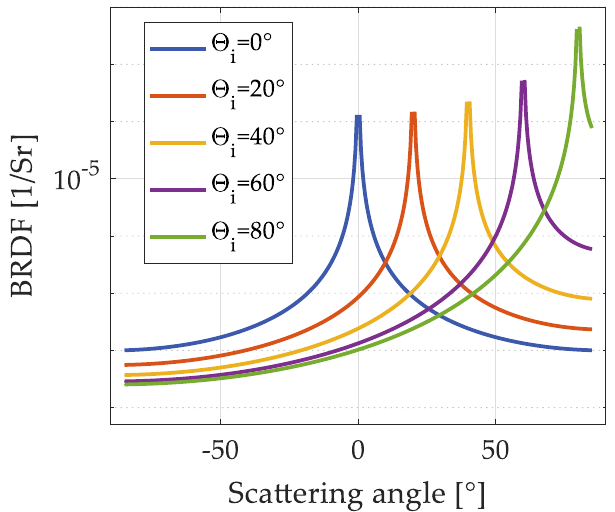
Figure 6. Scattering distribution simulation based on two-parameter Harvey model.